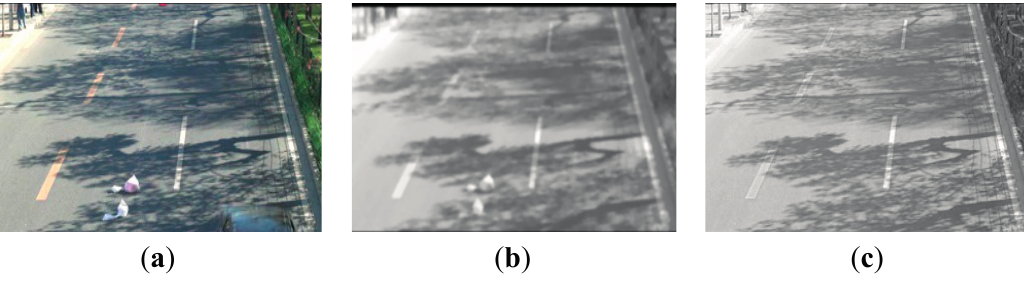
Figure 10. Dual-background model updating. ( a ) Frame with abandoned objects; ( b ) Short-term background; and ( c ) Long-term